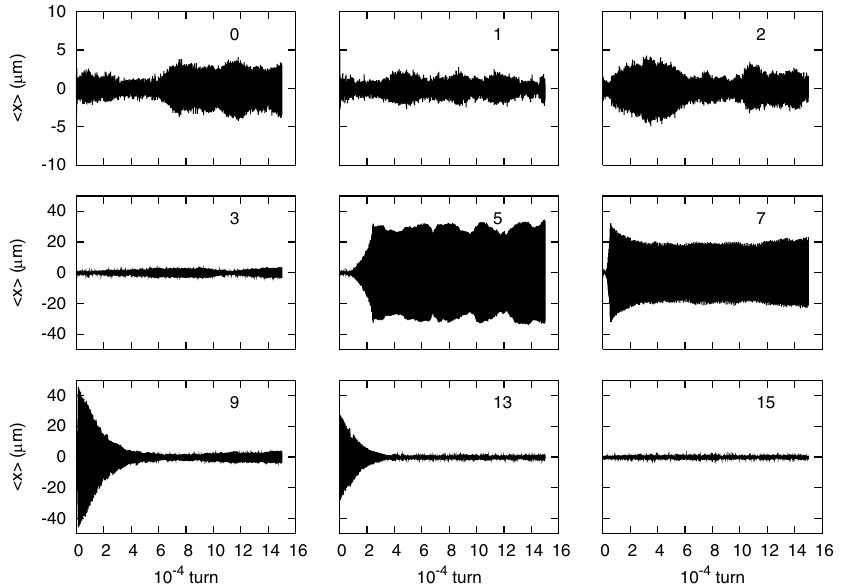
(cid:3) (cid:7) (cid:1) 0 : 51 ; 0 : 57 (cid:3) . The ; 7 x y